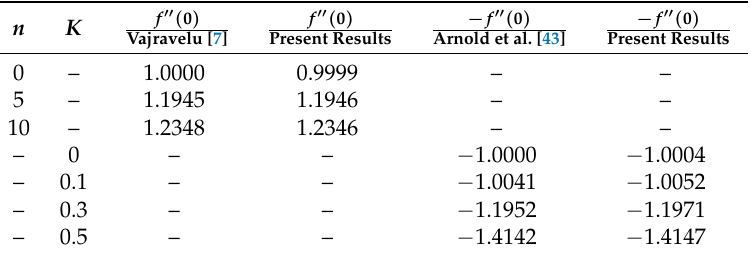
Table 1. Comparison of local skin friction f (cid:48)(cid:48) ( 0 ) at the wall for the present results and that of Vajravelu [7] when K = R = Q = Ec = 0 with that of Arnold et al. [43] for various values of K when M = Ec = 0.